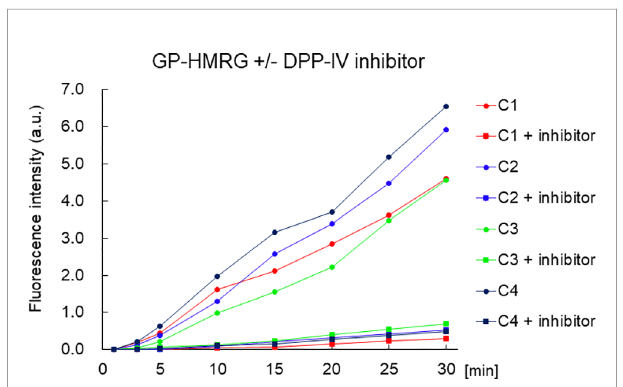
FIGURE 6 | The time course of the increase of FI of small cancer specimen with or without inhibitor. The fl uorescence intensity of the pancreatic cancer specimen was decreased with DPP-IV inhibitor. The concentration of the DPP-IV inhibitor (K579, CalbioChem) was 100